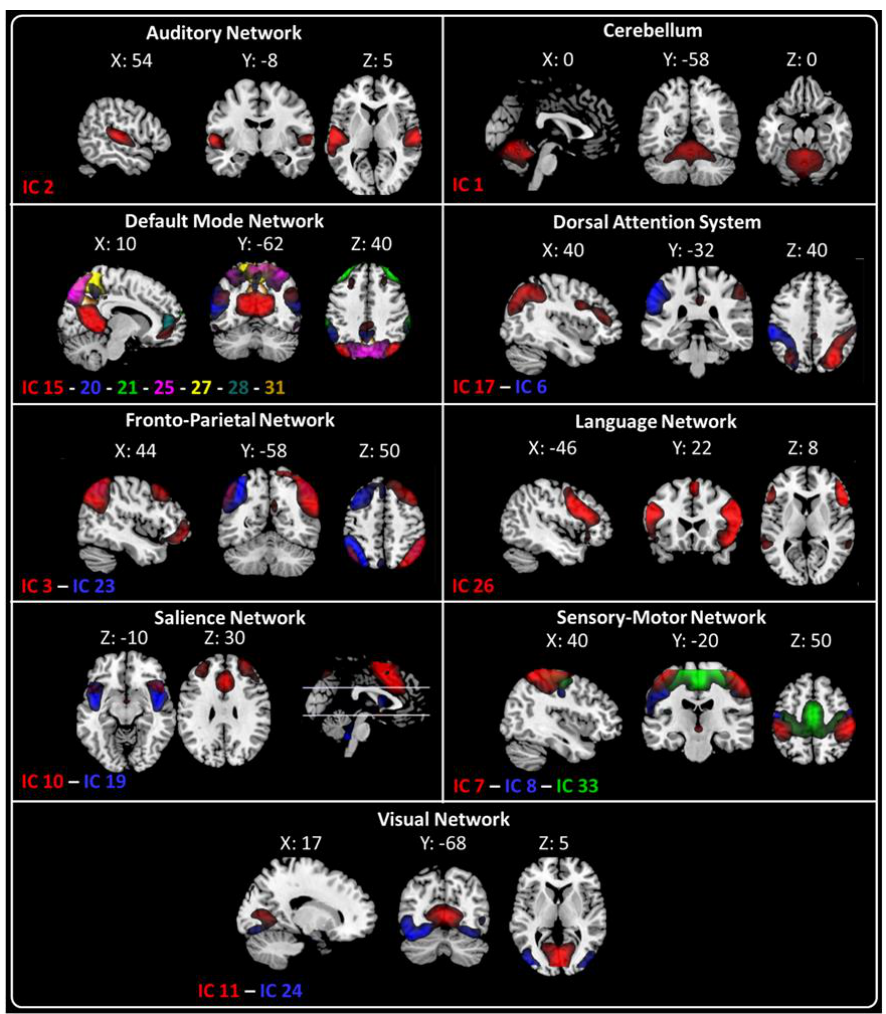
Figure 2. Twenty-one spatial maps divided into nine functional networks were found: